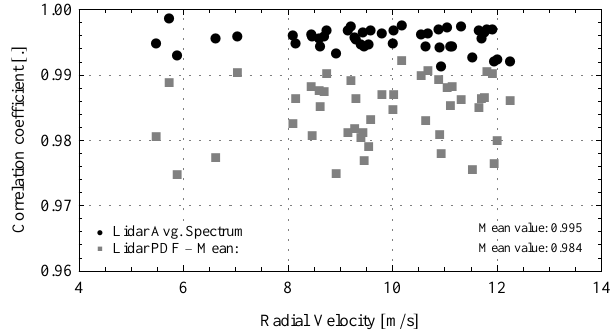
Fig. 4. Comparison of the lidar pdf and the lidar average spectrum with the sonic pdf by a correlation analysis. The radial velocity is the LOS velocity averaged over 10min.